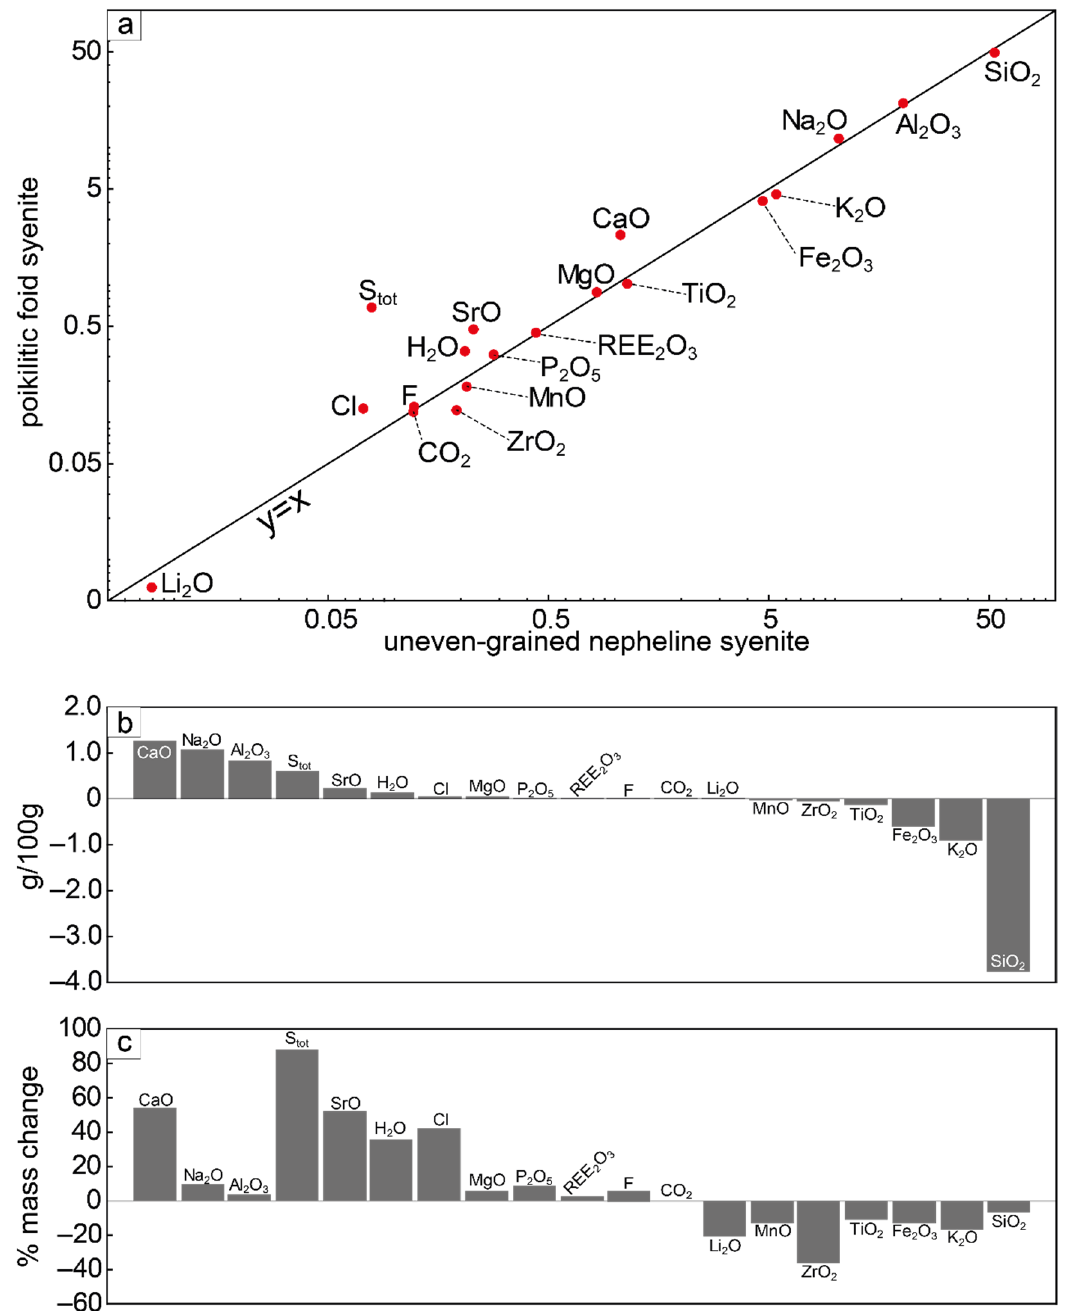
Figure 16. ( a ) Isocon diagram comparing the chemistry of poikilitic foid syenite (altered rock) and uneven-grained nepheline syenite (fresh rock); ( b , c ) bar diagrams showing the gains and losses of major oxides and elements.